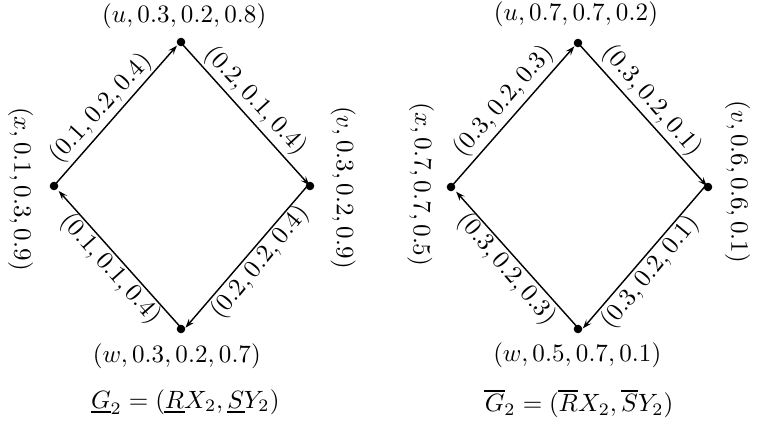
, G 2 ). 2 , G 2 ). 2 , G 2 ). 2